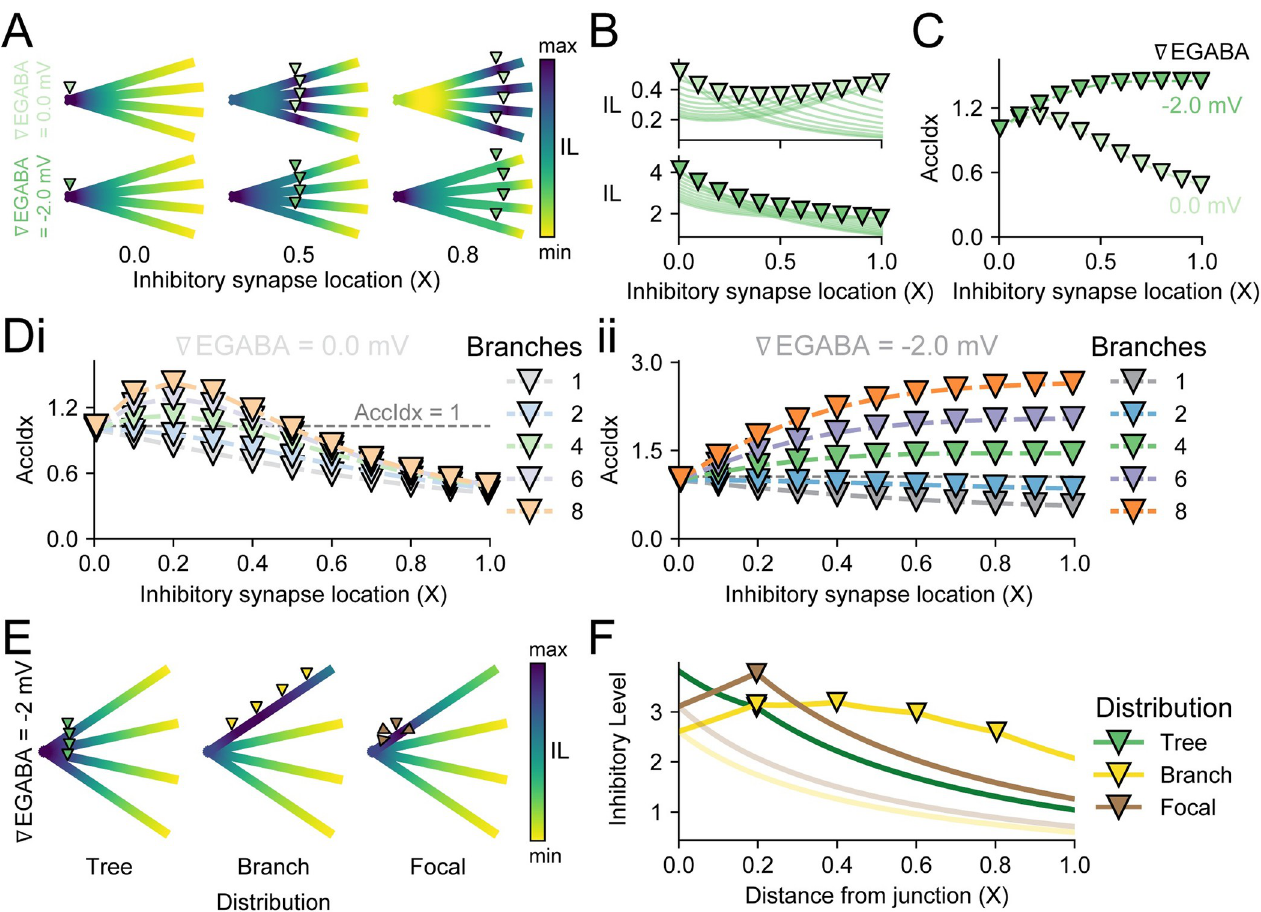
Fig 4. Location and distribution of inhibitory synapses differentially affect the Inhibitory Level. (A) Heatmaps show the maximum IL ( r EGABA = 0 mV, light green markers, top row or r EGABA = -2 mV, dark green markers, bottom row) for different inhibitory synapse locations, i, on a 4-branch dendritic structure. The inhibitory synapses are evenly placed from the junction (0.0 X in left column, 0.5 X in centre column, 0.8 X in right column). (B) The IL ( r EGABA = 0 mV, top and r EGABA = -2 mV, bottom) for each inhibitory synapse location i, in electrotonic units X, on a 4-branch dendrite. Each trace represents recordings at every excitatory input location D along the dendrite for a given synapse location i. Inhibitory synapses at the junction, i = 0 X, elicit the greatest IL. IL d = i for shunting synapses ( r EGABA = 0 mV) is the lowest when inhibitory synapses are between the junction and the end of the dendrite (0.4 X), yet IL d = i for hyperpolarising synapses ( r EGABA = -2 mV) is the lowest at the end of the dendrite (1.0 X). (C) The AccIdx for 4 branches with hyperpolarising synapses ( r EGABA = -2 mV) continues to increase, albeit with saturation, with farther locations for inhibitory synapses. Shunting synapses ( r EGABA = 0 mV), however, have their greatest AccIdx when i = 0.2 X. (D) The different trends in AccIdx between shunting (Di) and hyperpolarising (Dii) inhibitory synapses, as in ‘C’, holds for dendrites with more than 2 branches. For dendrites with 1 or 2 branches, the AccIdx is greatest when i = 0.0 X. For greater numbers of branches, the maximum AccIdx depends on whether the synapse is shunting or hyperpolarising. (E) The maximum IL is dependent on the distribution of the synapses. A dendrite with 4 branches can have 4 synapses placed in different configurations: evenly spaced from the junction on each branch (“Tree”), evenly spaced along a single branch (“Branch”), or all placed at a single location on a single branch (“Focal”). Inhibitory synapses were hyperpolarising ( r EGABA = -2 mV). (F) The IL values for the synapse distributions in ‘E’. Although the Tree configuration (green) produces an accumulative IL at the junction, the Focal distribution (turquoise) has the largest absolute IL (at d = i = 0.2 X), and the Branch distribution (lilac) facilitates a more even IL along its branch. However, both the Branch and Focal distributions are branch-selective and hence have to trade-off their gains for weaker ILs on their silent branches (lighter